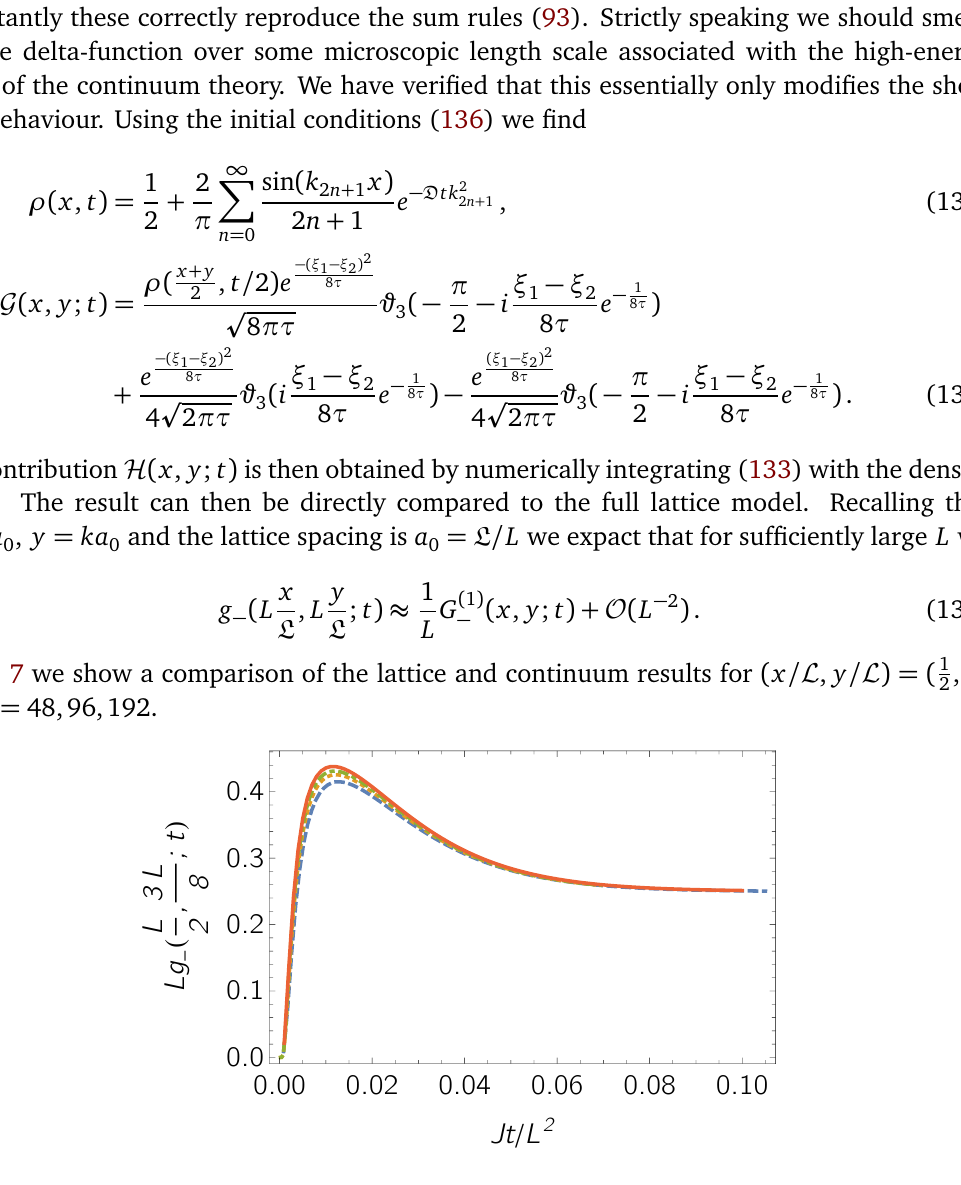
Figure 7: Comparison between g − ( L / 2,3 L / 8; t ) as a function of J t / L 2 on a ring of L = 48 (blue dashed), L = 96 (yellow dotted), L = 192 (gree dot-dashed) sites ( 1 ) ( x , y ; t ) (red solid). The continuum limit with domain wall initial conditions and G − result is approached throughout the depicted time range as L